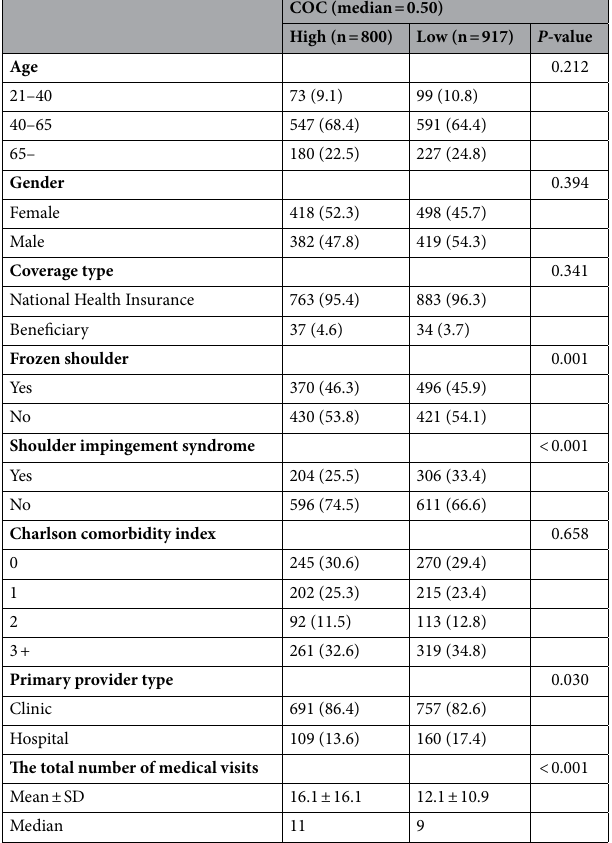
Table 1. Basic characteristics of patients. Values are presented as numbers (column percentages) for categorical variables and mean ± standard deviation (SD) for continuous variable. To examine difference between groups, the independent t test was used for continuous variables and chi-square test was used for categorical variables. COC Continuity of Care Index.